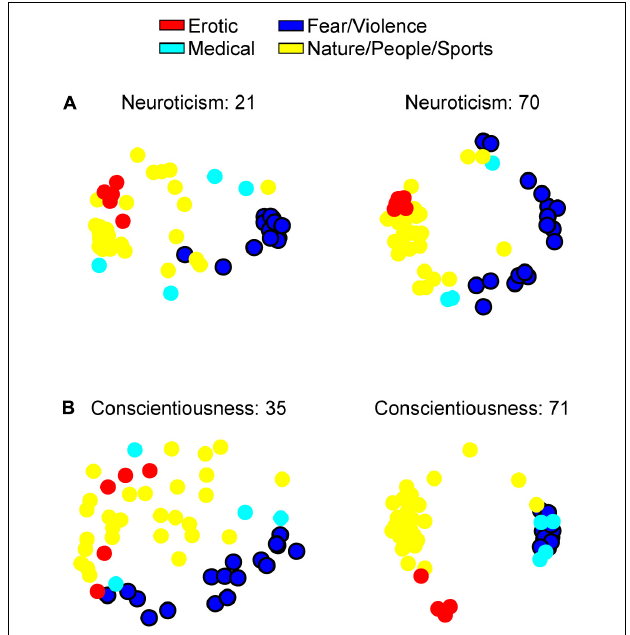
FIGURE 3 | Individualized affective spaces from the participants with the lowest and highest (A) Neuroticism and (B) Conscientiousness T-scores in our sample mapped onto two dimensions using multidimensional scaling solely to help visualize the effect underlying the multiple regression results, in this case those reported in section “Four-Cluster Solution: Opposite Dispersion Patterns of the Fear/Violence Cluster for Neuroticism and Conscientiousness.” Following the same color-scheme as in the previous figures, circles represent the 54 stimuli, and black contours are drawn around the stimuli that are members of the cluster whose dispersion was predicted by the multiple